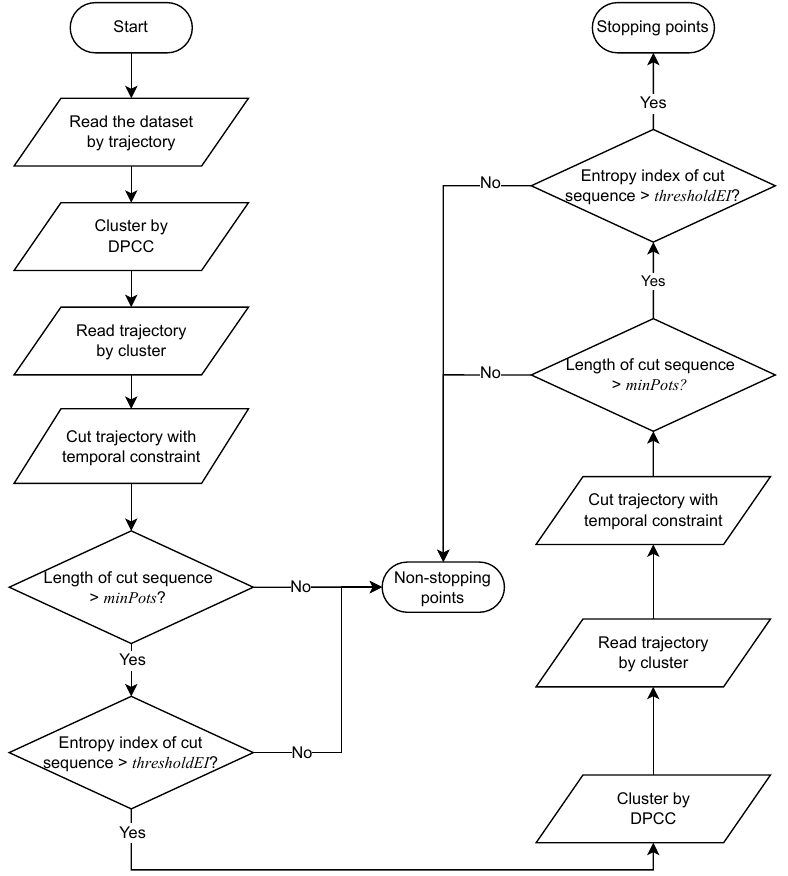
Figure 2. The structure of two-step DPCC-TE to extract stopping